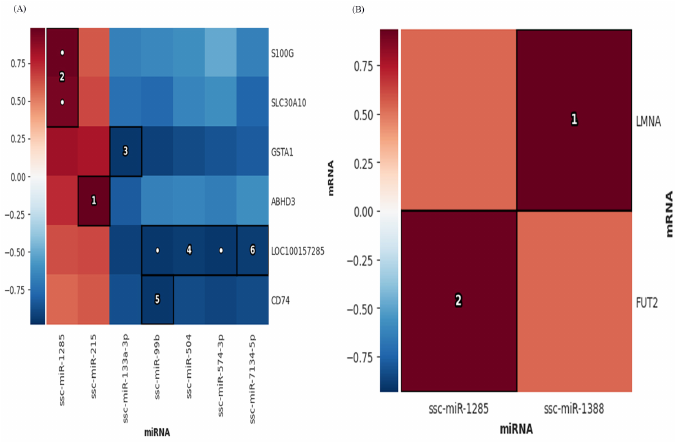
Figure 3. Association analysis of miRNAs and mRNAs. ( A ) Association results between miRNA and mRNA in the P set. ( B ) Association results between miRNA and mRNA in the I − V set. Color bars represent correlation coefficients: red for positive correlation and blue for negative